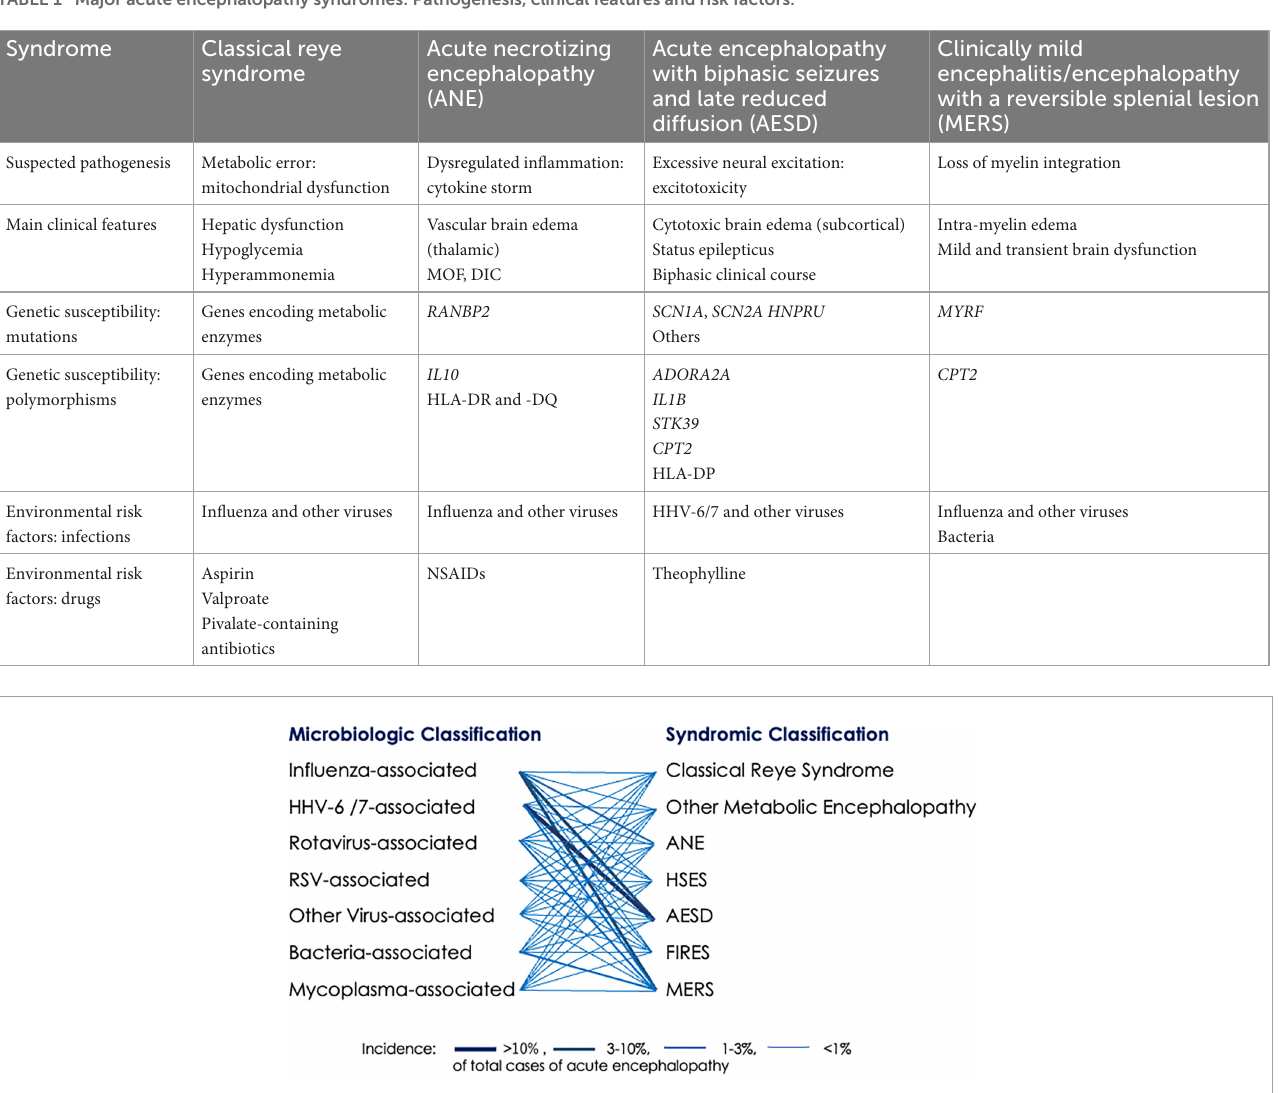
TABLE 1 Major acute encephalopathy syndromes: Pathogenesis, clinical features and risk factors.